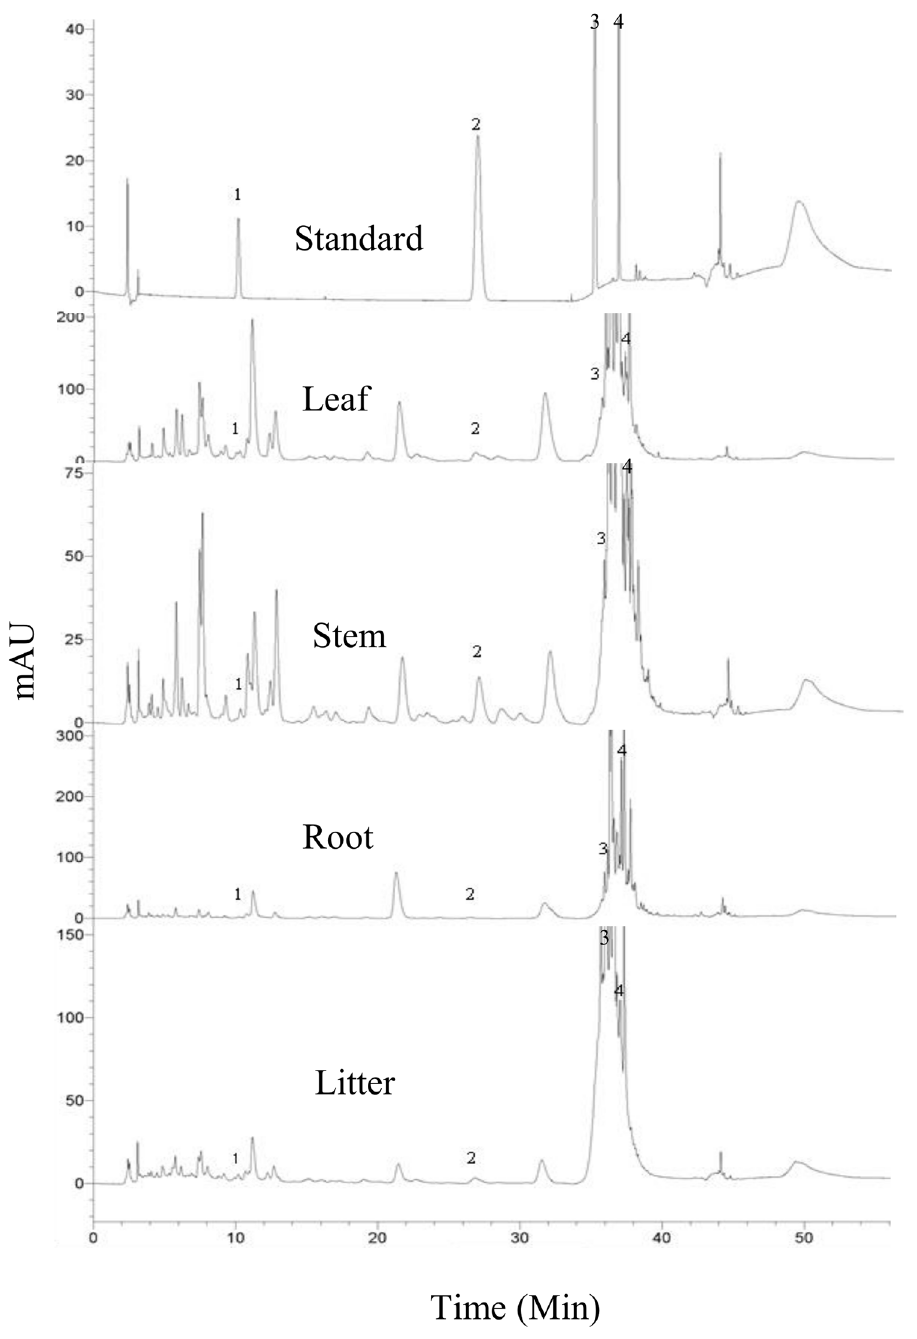
Fig 2. HPLC output. Chromatograms of standard phenolic compounds mixer (1 = Catechin, 2 = P-coumaric acid, 3 = ferulic acid, 4 = Phloridzin) and boneseed tissue (leaf, stem, root and litter) extracts. X-axis represents the retention time (min) and y-axis represents the unit